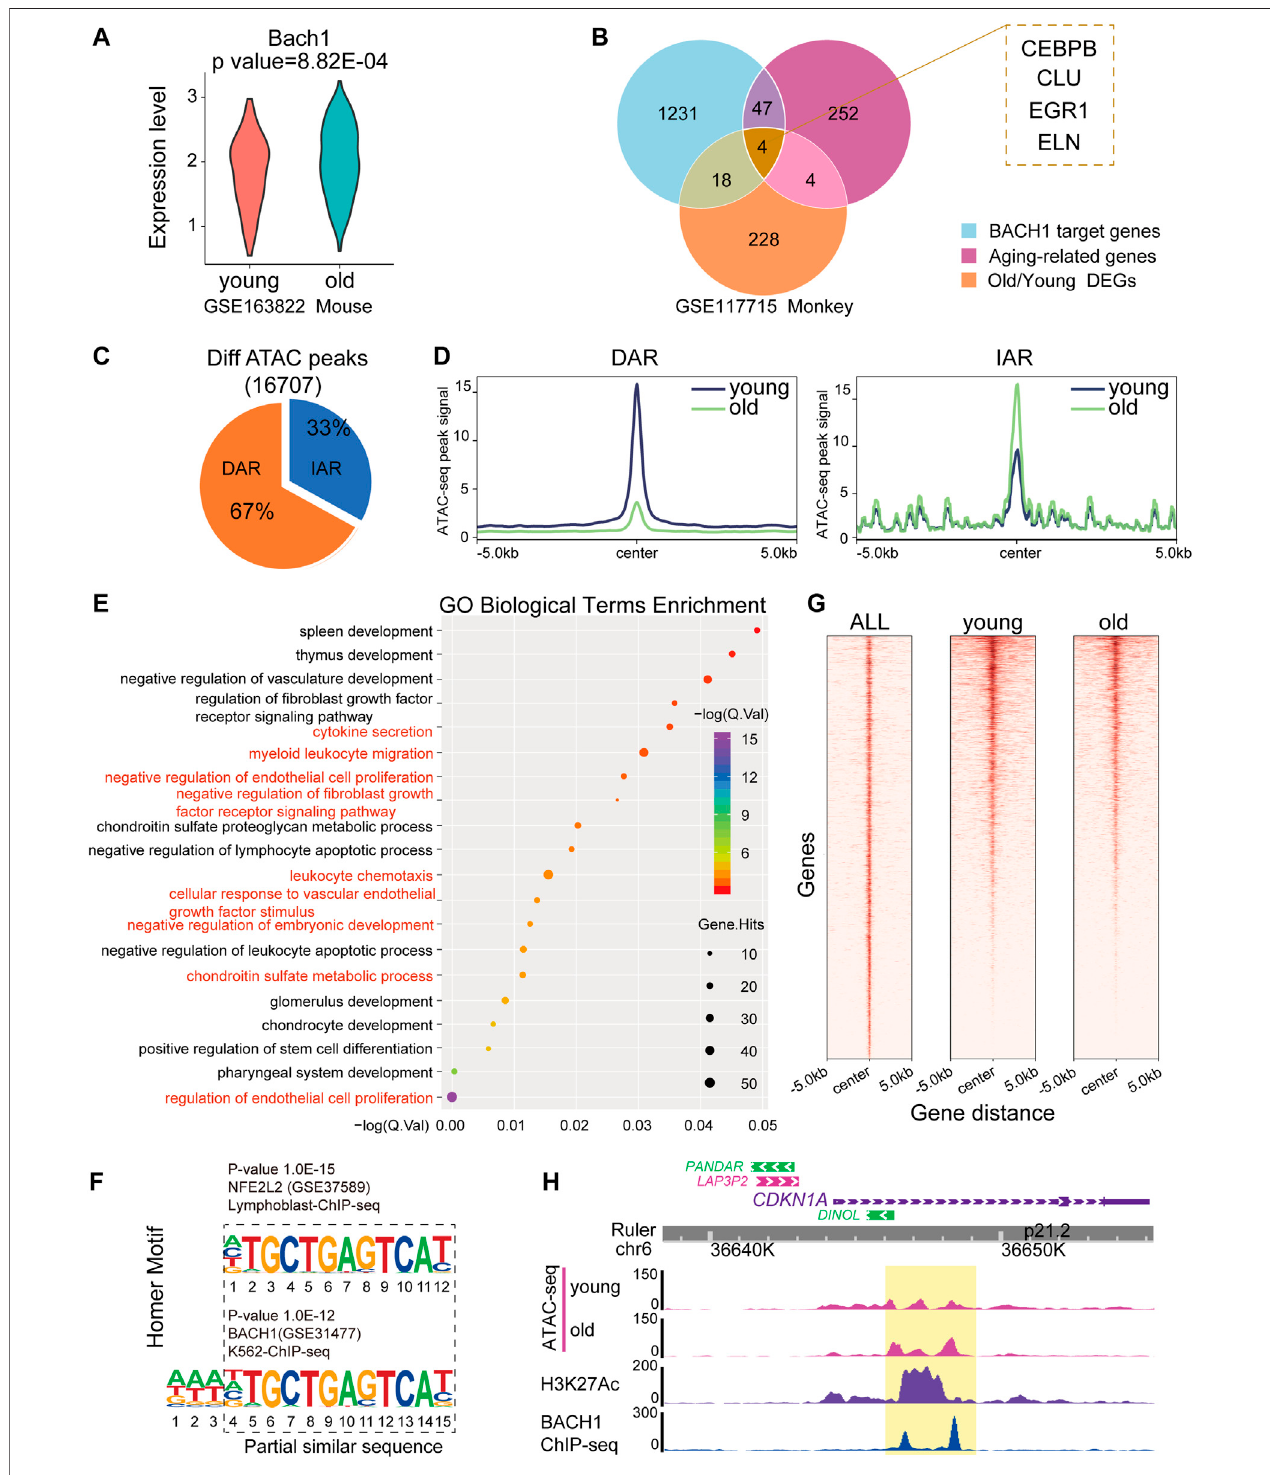
FIGURE 3 | ATAC-seq analysis of young and senescent ECs. (A) Violin plot showing normalized expression of BACH1 in mouse ECs. (B) Venn diagram showing overlappingof1) old/youngmonkey DEGs; 2) aging-related genesfromGenAgedatabase,and3)targetgenes ofBACH1from ChEA3and TRRUSTresources. (C) Piechartof differentialATAC-seqpeaksidenti fi edbyMACS2.Duringsenescence,theaccessibilityofsenescence-relatedpeaksincreasedordecreasedisde fi nedasincreasedaccessibility regions(IARs)ordecreasedaccessibilityregions(DARs). (D) TheATAC-seqsignalsofyoungsamplesinIARsandDARsaredifferentfromthatofoldsamples(regioncenter ± 5 kb). (E) GO enrichment analysis of IARs performed on the GREAT server. The aging and endothelial-related terms are highlighted in red. (F) The known transcription factors ’ motifs of differential peaks of ATAC-seq. (G) Heatmap of BACH1-binding pro fi les and ATAC-seq of young and old at BACH1-enriched regions (region center ± 5 kb). (H) Representative snapshots of ATAC-seq of young and old samples, ChIP-seq of H3K27Ac and BACH1 tracks on the enhancer and promoter neighboring CDKN1A .